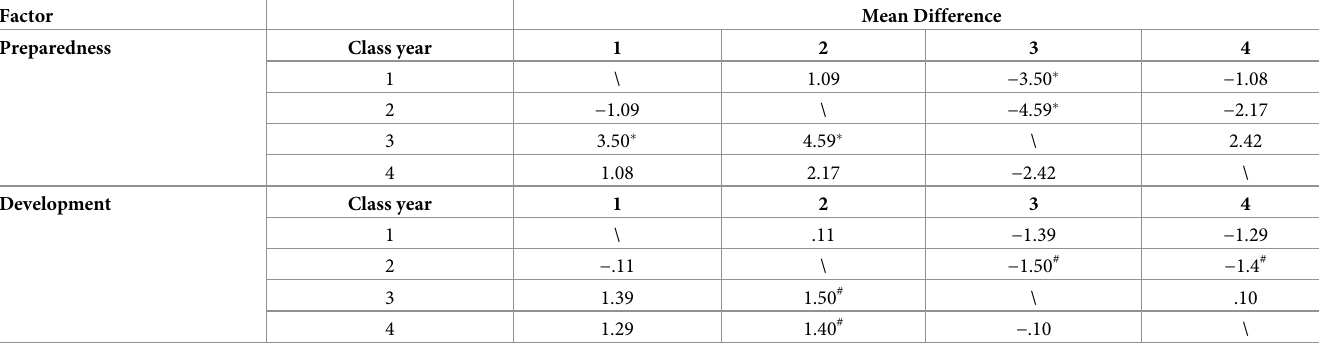
Table 3. The multiple comparisons of preparedness and